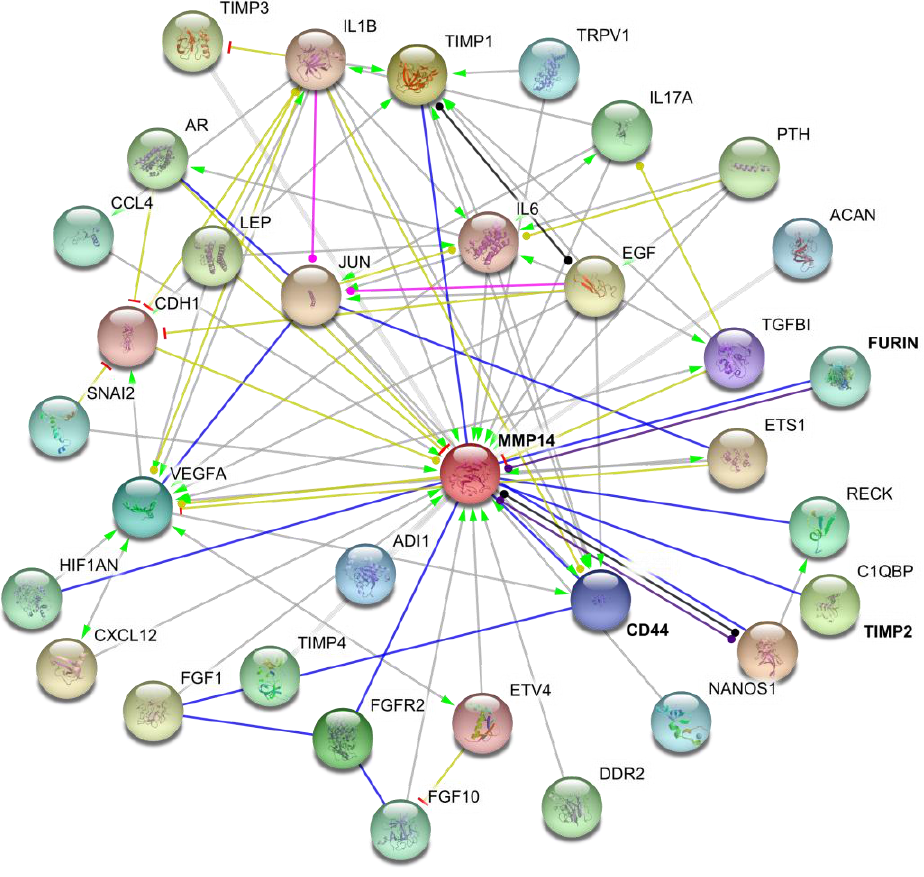
Figure 3. Interactions of MT1-MMP (MMP-14) with different cellular partners. Interaction map generated using STRING database